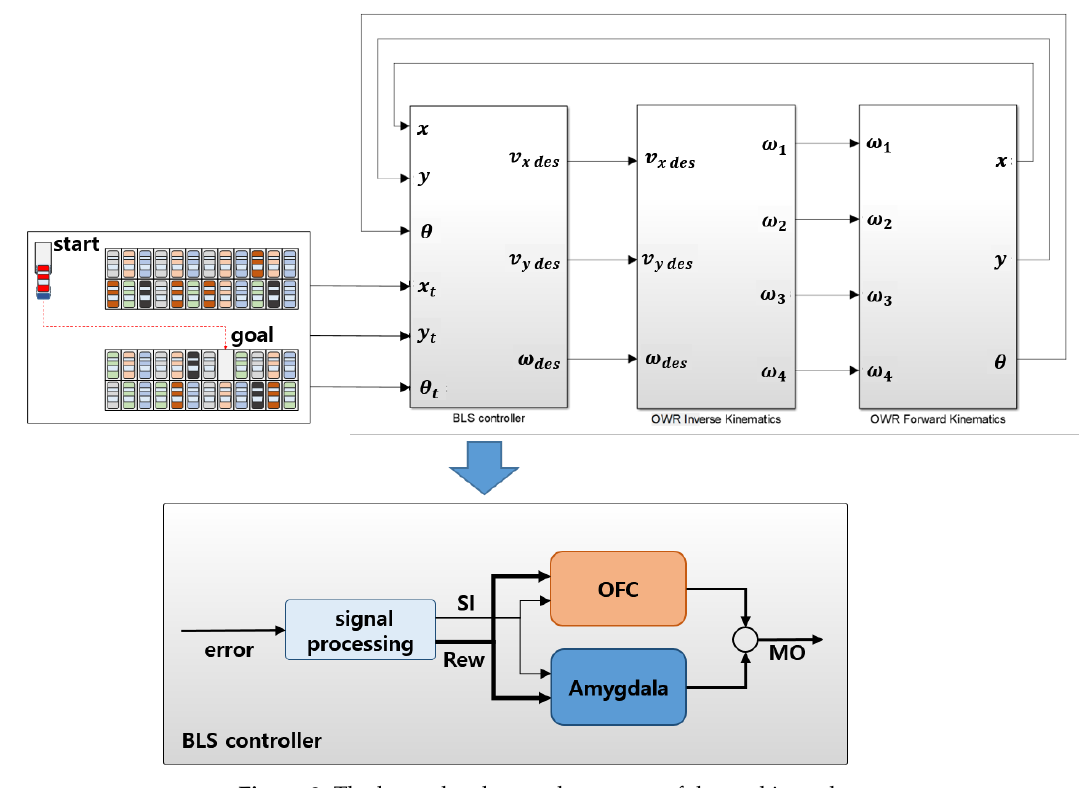
Figure 3. The lower-level control structure of the parking robot.